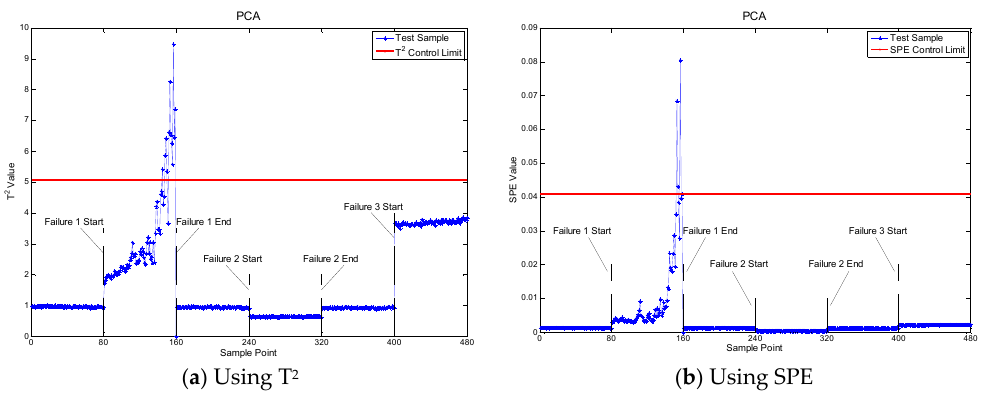
Figure 5. Fault detection with